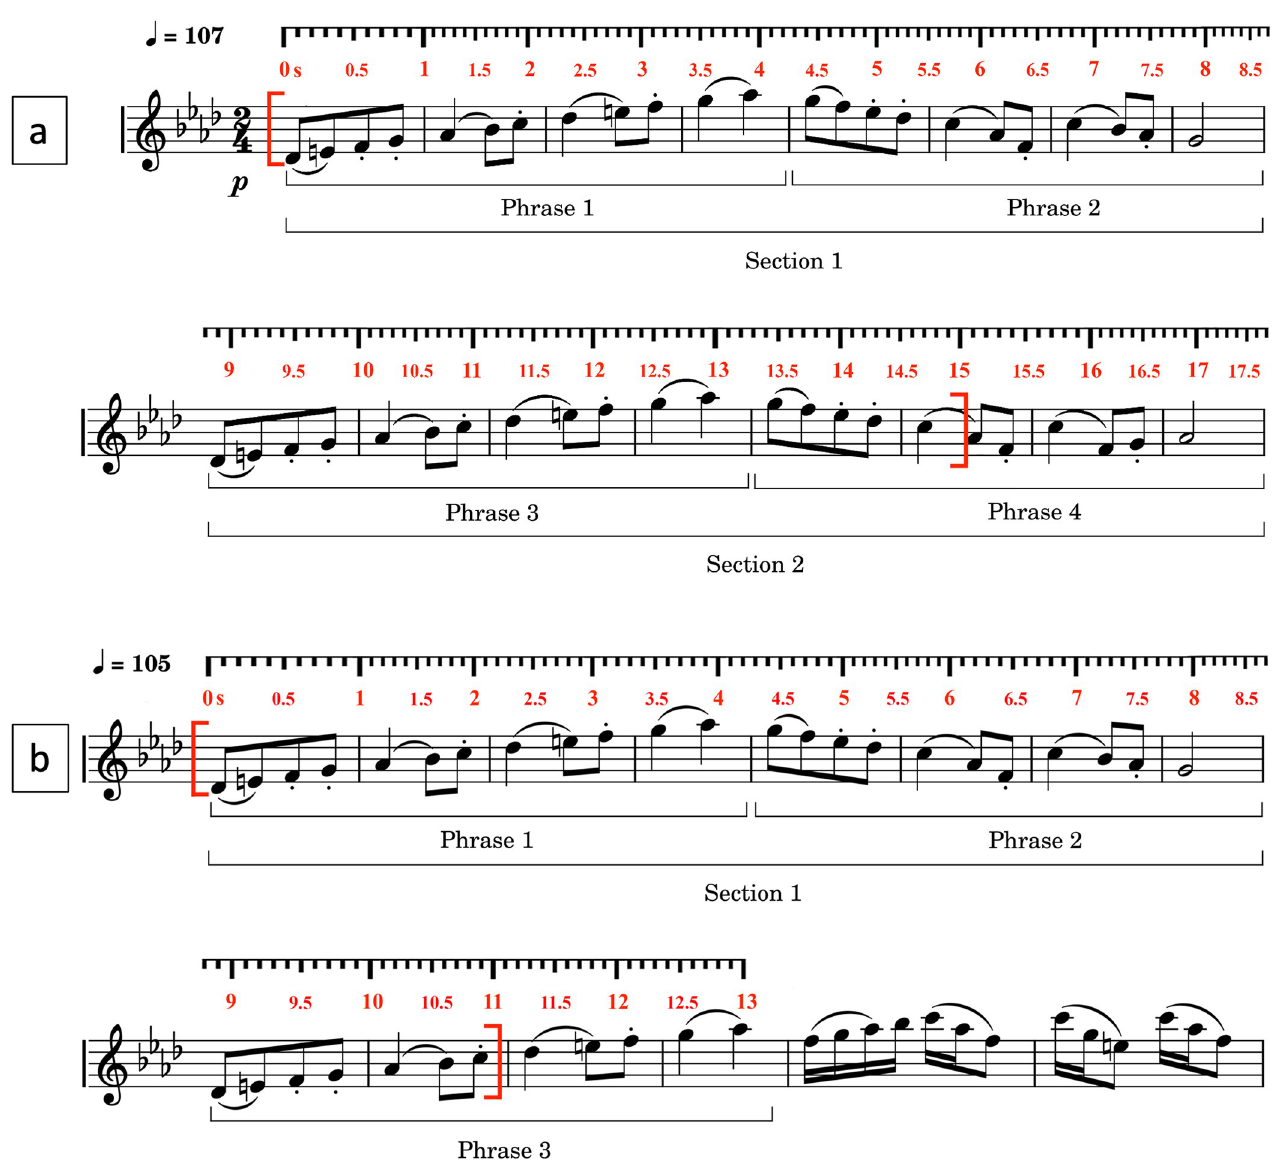
Fig 1. The score of the musical fragments from the Odile variation, act 3, Swan Lake. In a) I.F1 and F1 is displayed, consisting of two symmetric sections and four phrases. This fragment lasts 18 seconds, and the tempo is 107.0 ( ± 2.8) bpm for a 4 th note. In b) F2 is displayed, consisting of three phrases. This fragment lasts 13.7 seconds, and the tempo is 105.5 ( ± 2.2) bpm for a 4 th note. Fragments were truncated to 15 (I.F1 and F1) or 11 (F2) seconds to avoid artifacts resulting from the transition phase between dance techniques.